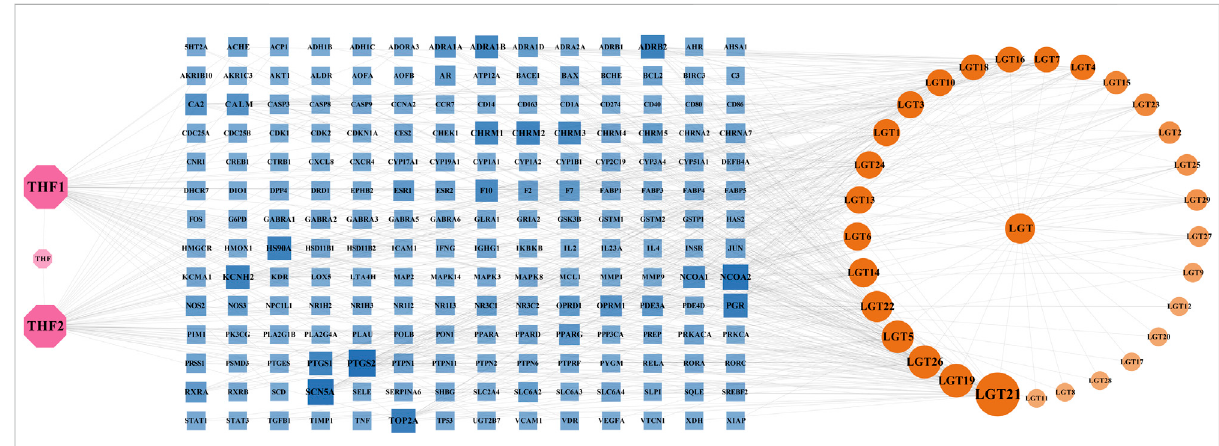
FIGURE 1 Network of herb-component-target. The pink nodes represented 2 active components of Trichosanthes kirilowii Maxim , the yellow nodes represented 29 active components of Tripterygium wilfordii Hook.F ., and thebluenodes represented 196 targets related to thecomponents of LTD. The nodes with a larger area and darker color have a larger degree